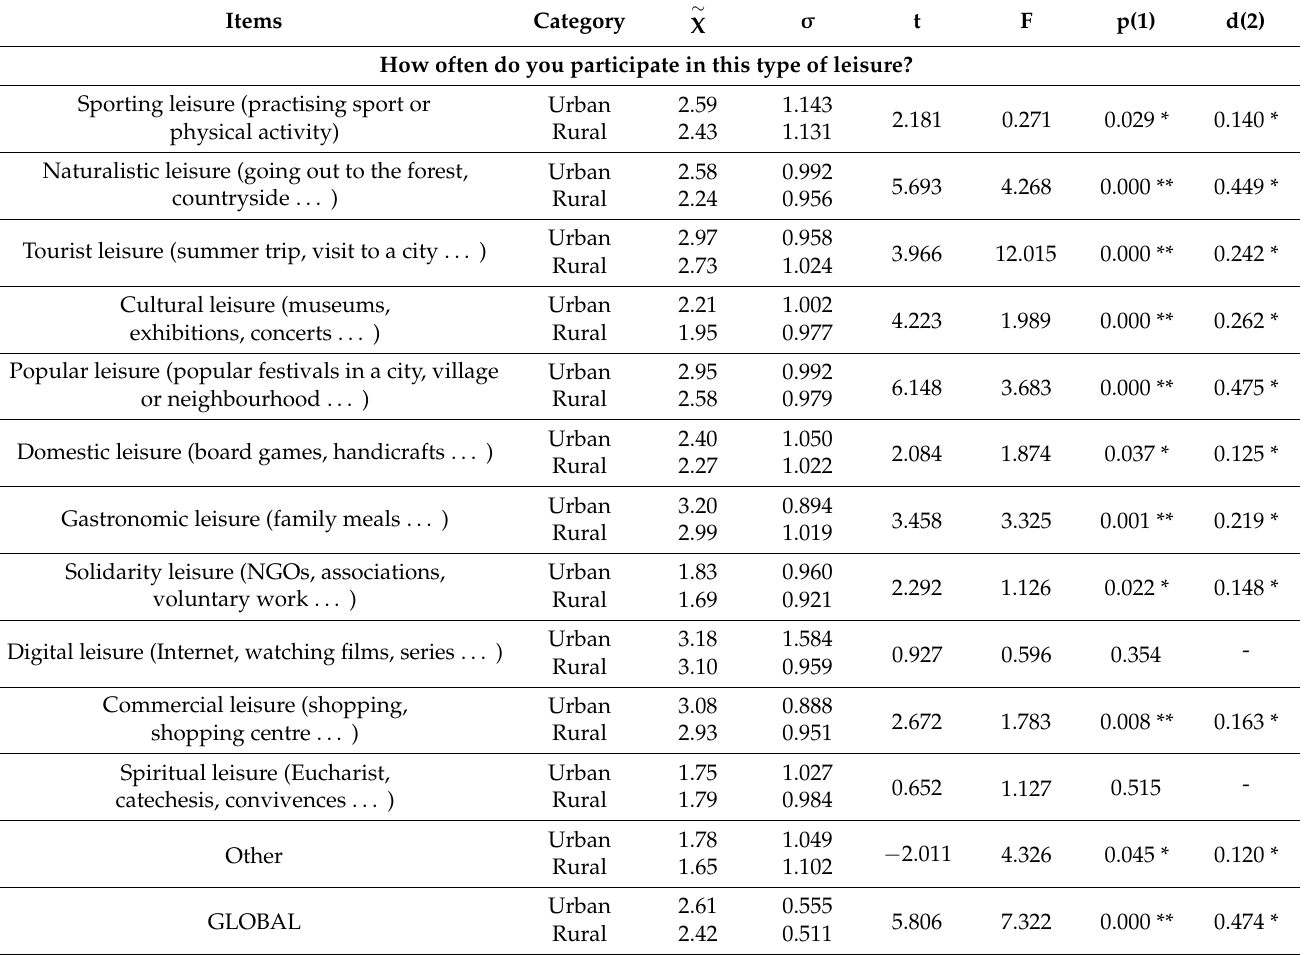
Table 4. Descriptive and inferential statistics of family leisure typologies as a function of the context.